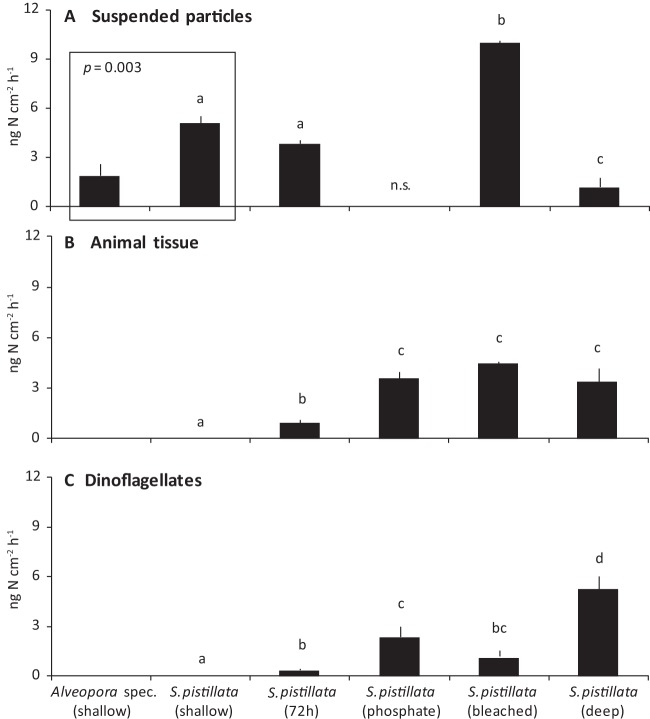
N2 fixation by suspended particles (A), as well as DDN assimilation by animal tissue (B) and dinoflagellates (C) after incubation of Alveopora species (shallow) and S. pistillata (shallow, 72 h, phosphate, bleached, and deep) coral colonies (ng N cm−2 h−1; mean ± SE). The suspended particles from the S. pistillata (phosphate) incubation were not sampled (n.s.) for analysis. Different letters (a to d) above the bars indicate significant differences between the S. pistillata incubations (one-factor PERMANOVAs with pairwise MC tests; significance level, P < 0.05). A separate PERMANOVA was conducted to compare N2 fixation by suspended particles between Alveopora species (shallow) and S. pistillata (shallow) corals (no significant 15N excess enrichment, and thus no DDN assimilation, was detected in the animal tissue and dinoflagellates of these corals).